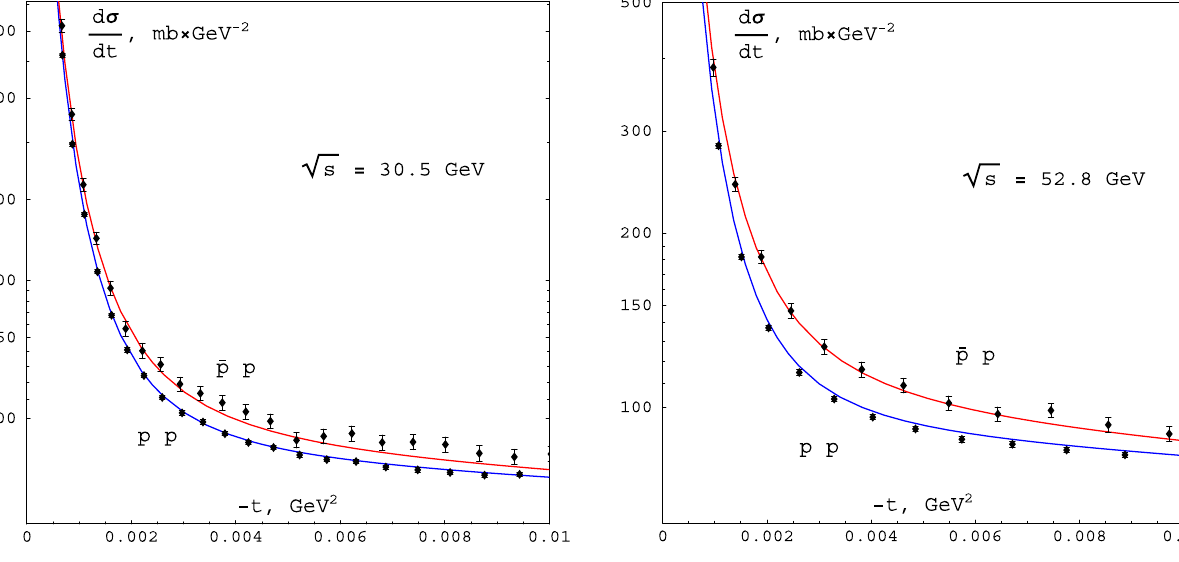
Fig. 9 The differential cross-sections of the p p and ¯ p p EDS at the ISR energies in the CNI